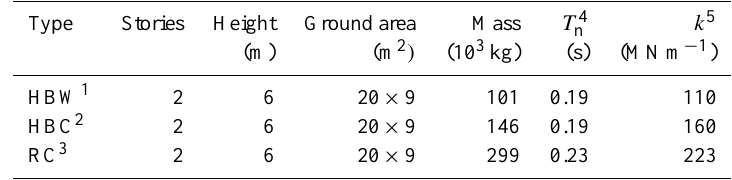
Table 2. Parameters of the modelled building